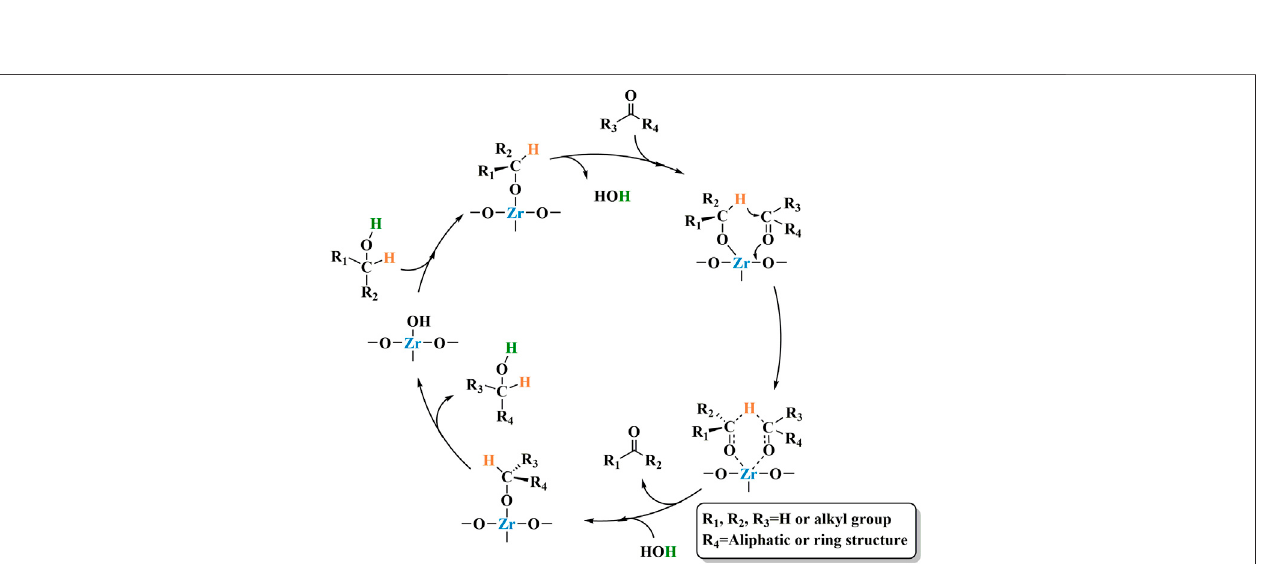
SCHEME 3 | The mechanism for the CTH of HMF into BHMF over ZrO(OH) 2 (Hao et al.,